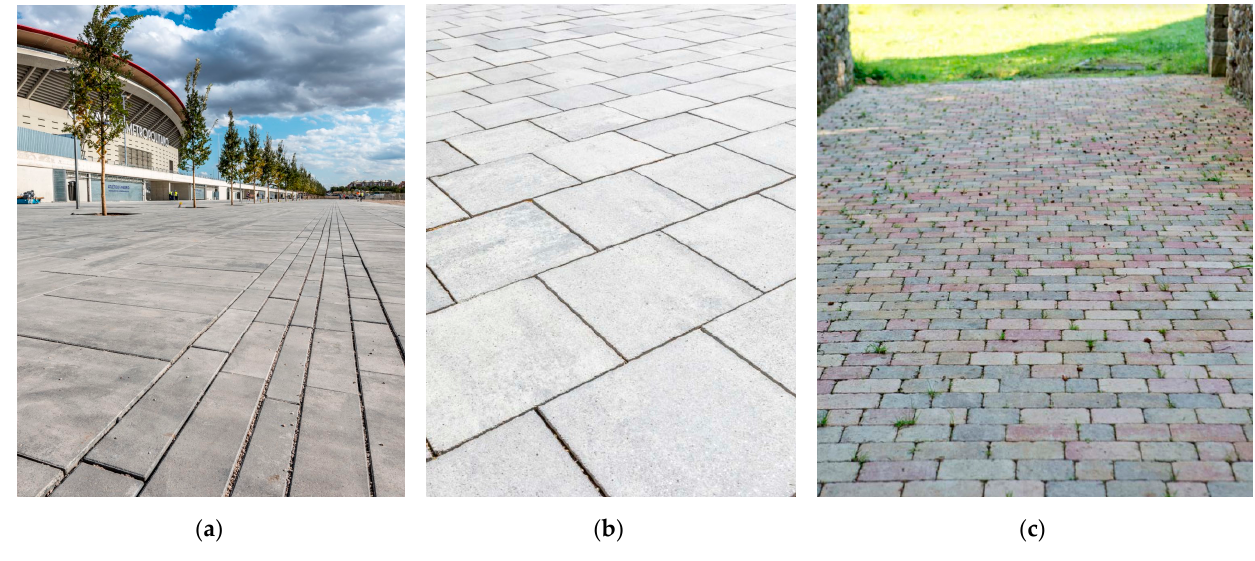
Figure 5. Albedo in some pavement applications: ( a ) Wanda 1 (0.30); ( b ) Titanium (0.57); ( c ) Dolomite (0.54).